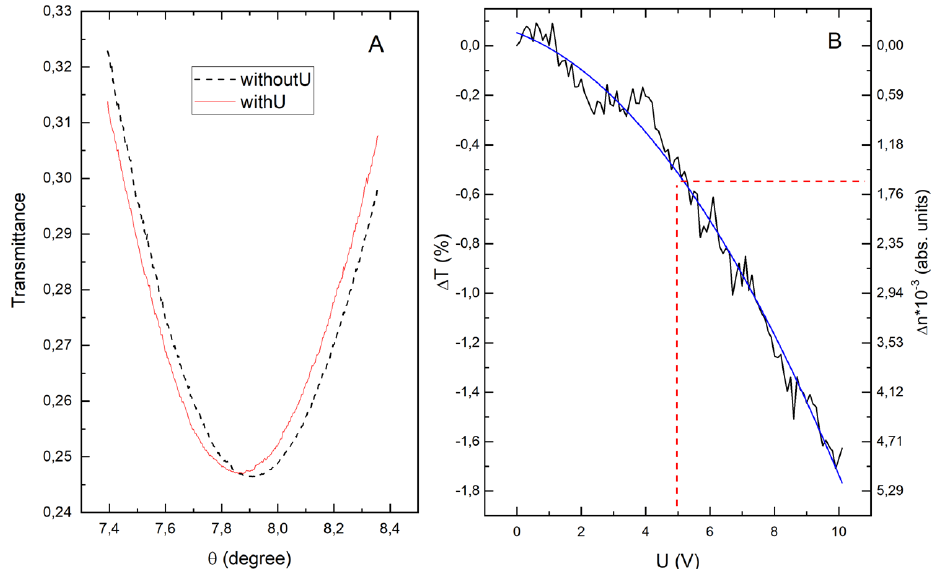
Fig. 5. (A) Angular distribution of the coefficient of transmission through a HES at 1.55 μ m wavelength without (black, dash-dotted line) and with a 8 V voltage (red, solid), (B) The dependence of the transmittance change of a HES on voltage (black ) and the corresponding simulated change in the effective refractive index of the active region of the HES